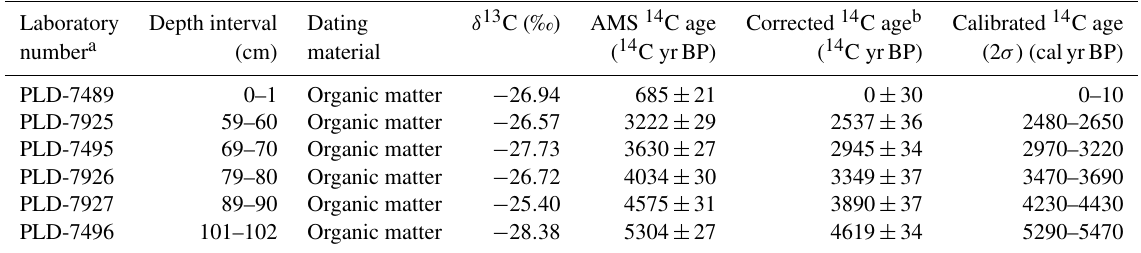
Figure 3. Time series of sand fraction (%) (Xiao et al., 2009), littoral ostracode valves (valvesg − 1 ) (Zhai et al., 2011), Chenopodiaceae pollen (%) (Wen et al., 2010a), and mean annual precipitation (mm) (Wen et al., 2010b) from the HL06 core spanning the period between 5000 and 3000cal.yrBP as well as the PCA F1 obtained from the aforementioned four proxies. The chronology was derived from the carbon- reservoir-corrected age–depth model; ages of sampled horizons were determined by linear interpolation between radiocarbon-dated horizons using the mean values of 2 σ ranges of calibrated ages (Xiao et al., 2009). Vertical dashed lines show the averages and 1 standard deviations above and below the averages of each proxy data as well as PCA F1 values during the period between 5000 and 3000cal.yrBP. Light grey bars mark the intervals at which each proxy or PCA F1 has values higher than 1 standard deviation (lower than 1 standard deviation for mean annual precipitation). Table 1. AMS radiocarbon dates of samples from the segment of the HL06 core between 105 and 55cm at core depth (covering the period between 5000 and 3000cal.yrBP). The radiocarbon date of the uppermost 1cm of the core sediments used for carbon reservoir correction is shown. Modified after Xiao et al.